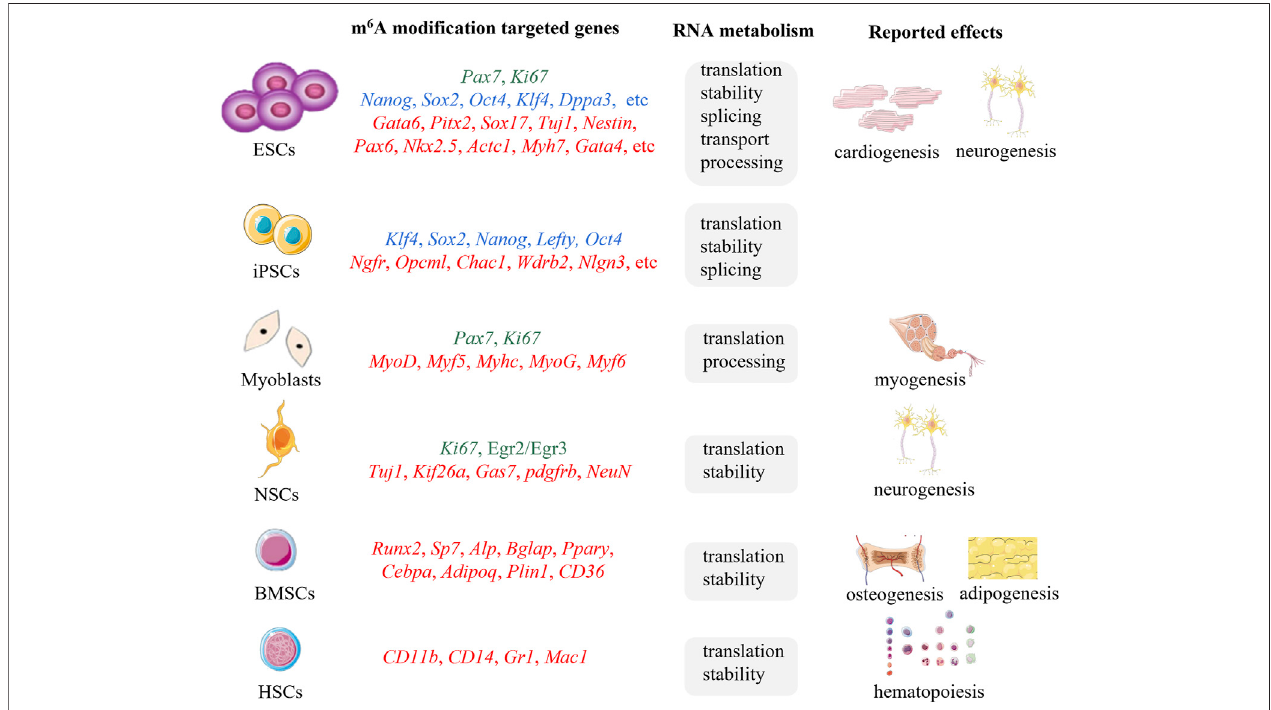
FIGURE 2 | The m 6 A modi fi cations targeted genes, associated RNA metabolic mechanisms, and reported effects of ESCs, iPSCs, myoblasts, NSCs, BMSCs, HSCs. Proliferation associated genes (green), pluripotency related genes (blue), differentiation associated genes (red).